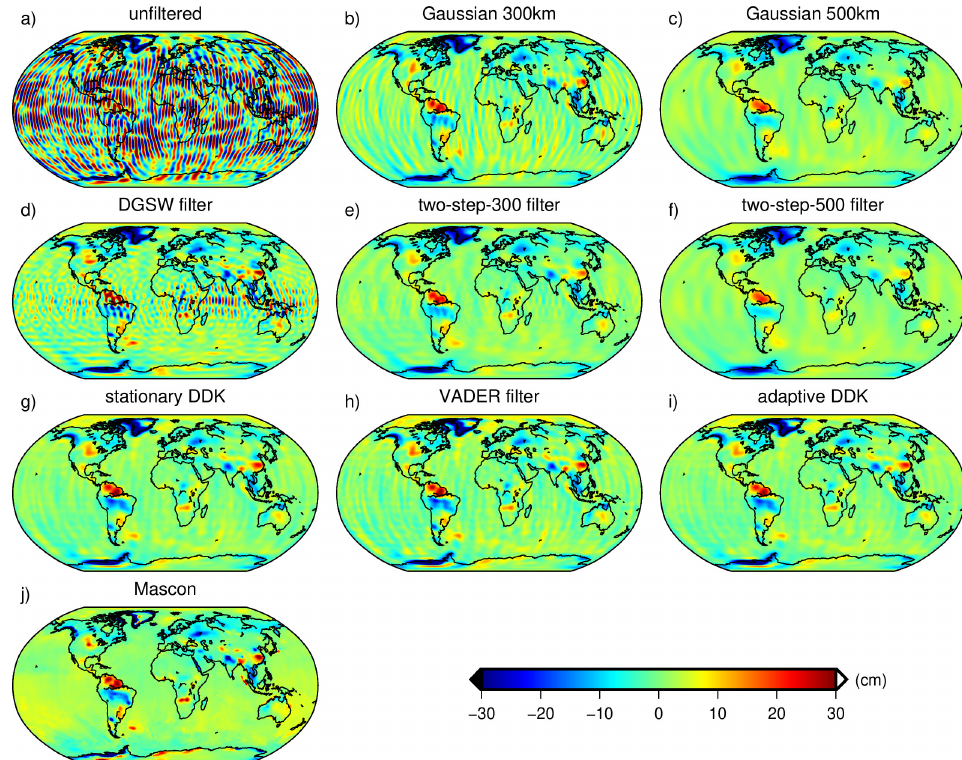
Figure 6. The unfiltered and filtered solutions expressed in EWH in July 2010. Note that the ECMs in all DDK filters are the same and the hyperparameters in them are optimized according to the GCV criterion. Table 2. The statistics of filtered global mass anomalies in terms of EWH (cm) in September 2006 and July 2010. Filtered